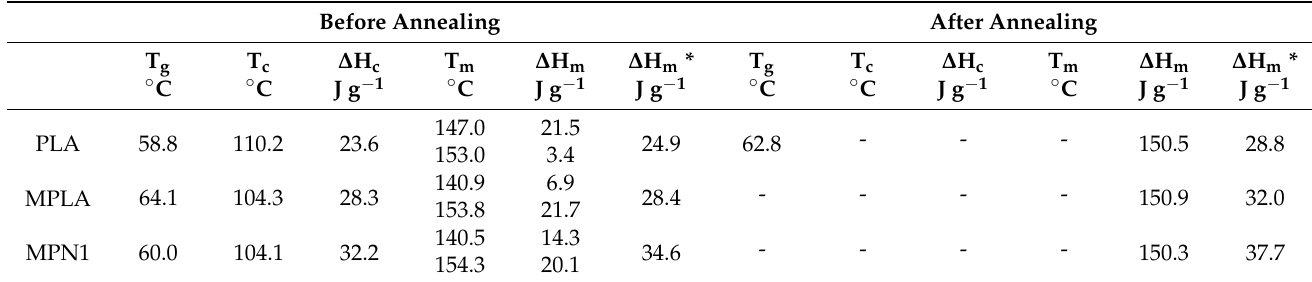
Figure 2. DSC curves during the first heating scan of MPLA and its biocomposites before ( left ) and after ( right ) thermal annealing. Table 2. DSC data corresponding to the first heating scan of MPLA and its biocomposites before and after annealing.